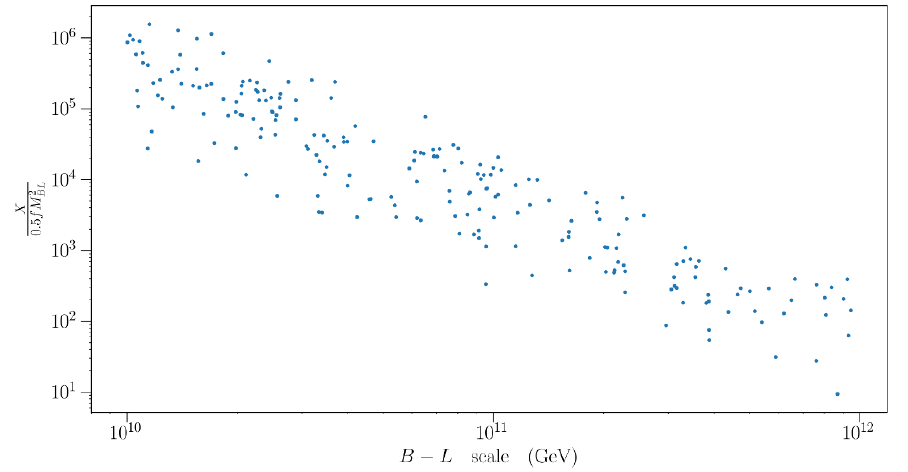
Figure 7. Log-log plot of X against the B - L scale, for the valid black points shown in (cid:12)gure 5 1 fM 2 BL 2 from the scan of 50 million sets of initial conditions. The quantity X of (cid:12)ne-tuning required to achieve the associated value of the B - L scale. The expression for X is presented in appendix